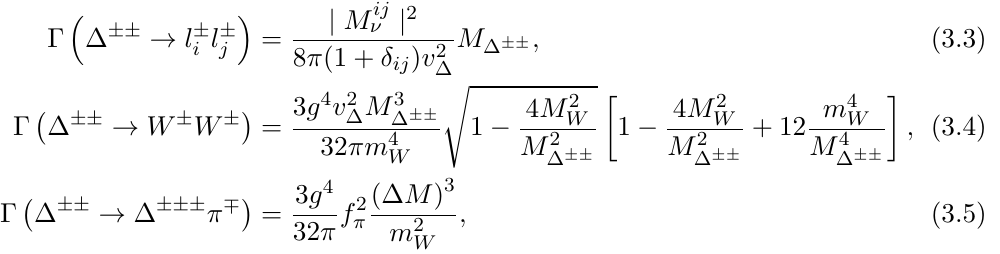
for v (cid:1) = 40 (cid:1) (cid:6)(cid:6)